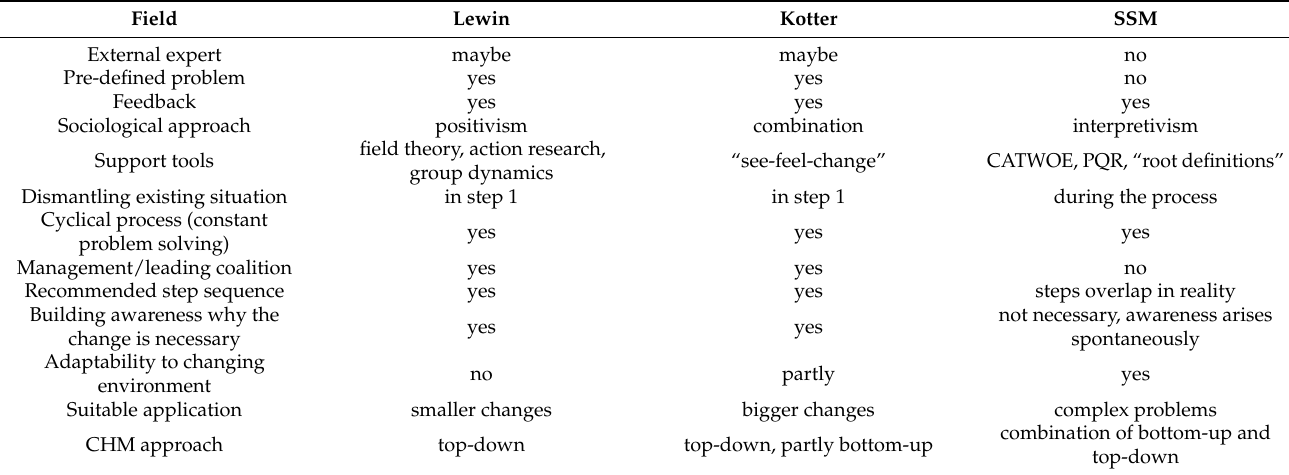
Table 1. Comparing basic characteristics of selected CHM